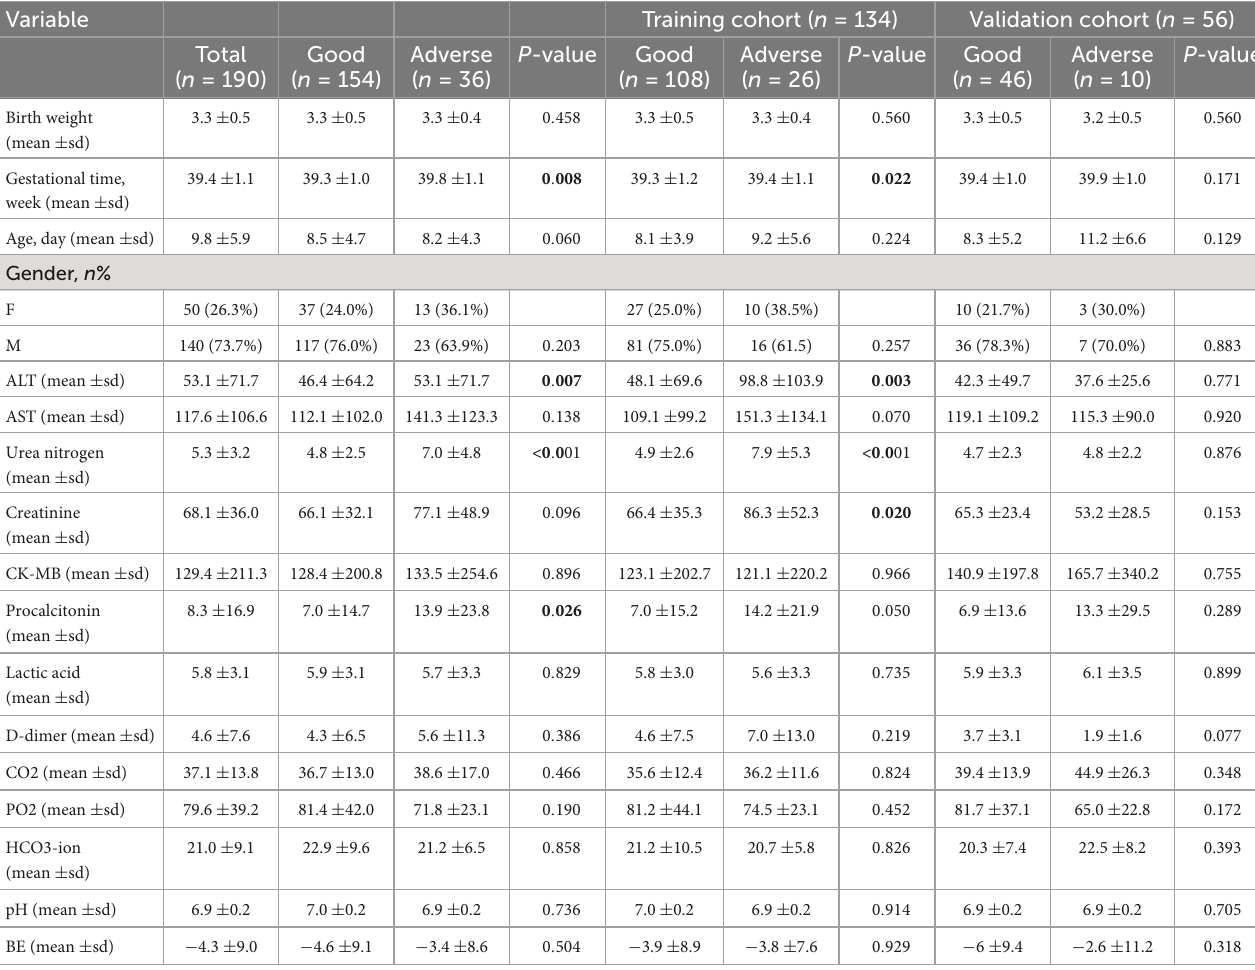
TABLE 2 Comparison of demographic, clinical, laboratory features between good, and poor outcome groups.